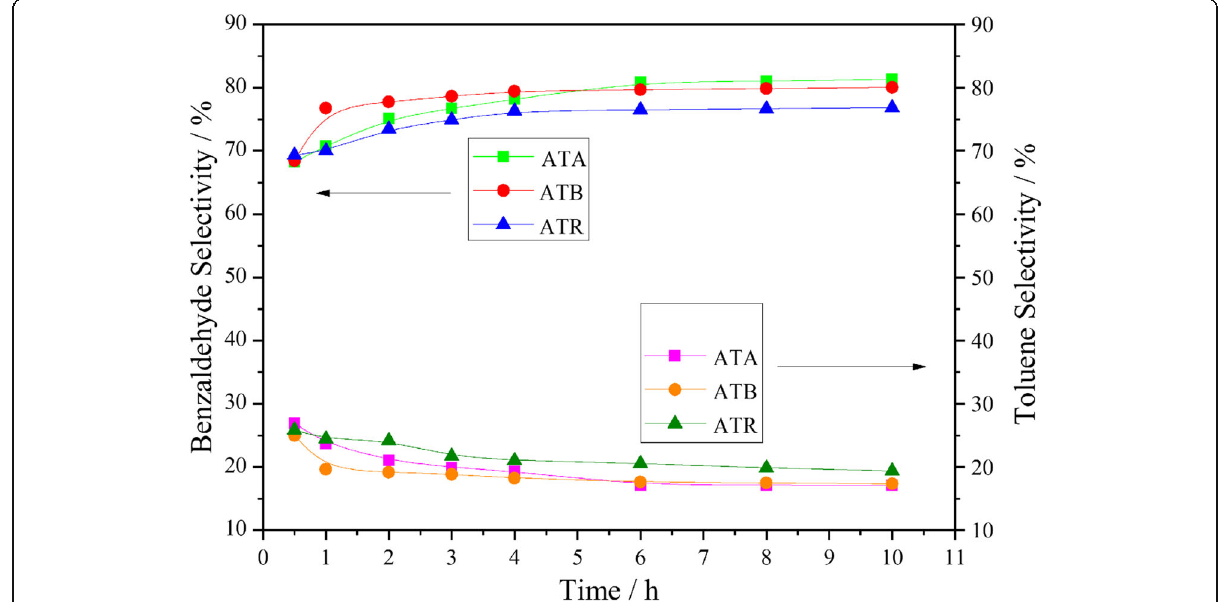
Fig. 5 Benzaldehyde and toluene selectivities as a function of time obtained on the ATA, ATB, and ATR